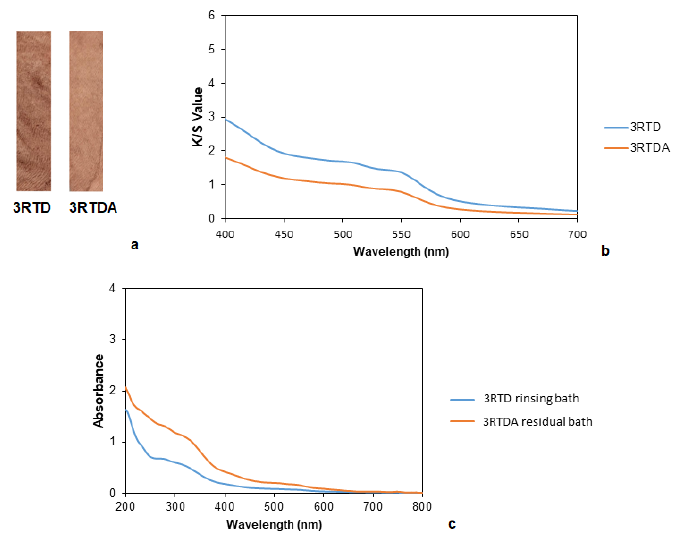
Figure 9. ( a ) Samples dyed with common madder without and with rinsing, ( b ) K/S values of samples dyed with common madder without (3RTD) and with rinsing (3RTDA). ( c ) Absorbance curves of the residual dyeing bath and rinsing bath of the samples dyed with common madder. Table 13. Colorimetric values obtained for the samples dyed with common madder without and with rinsing.